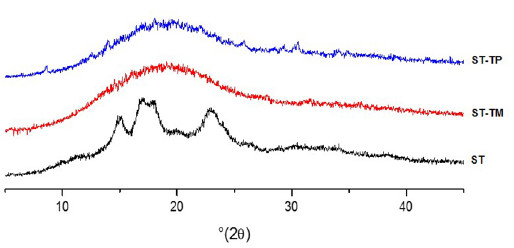
Figure 5. Diffractograms of ST, ST-TM and ST-TP samples. Table 3. Methylene blue adsorption isotherms data on the phosphorylated samples, using Langmuir and Freundlich models. Langmuir